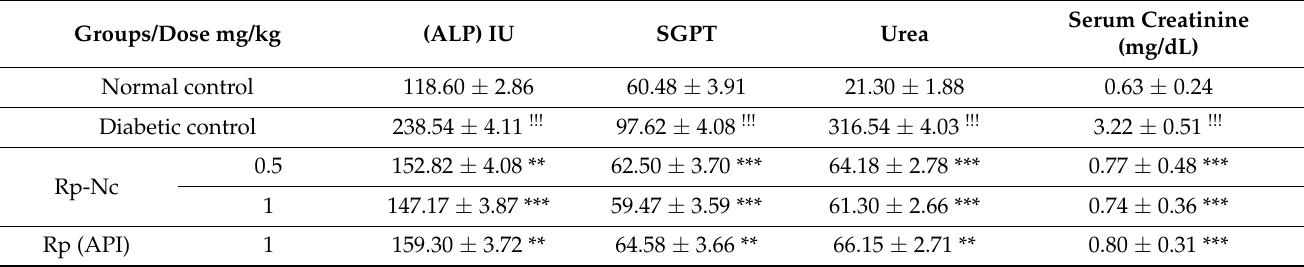
Table 7. Effect of Rp-Nc on liver